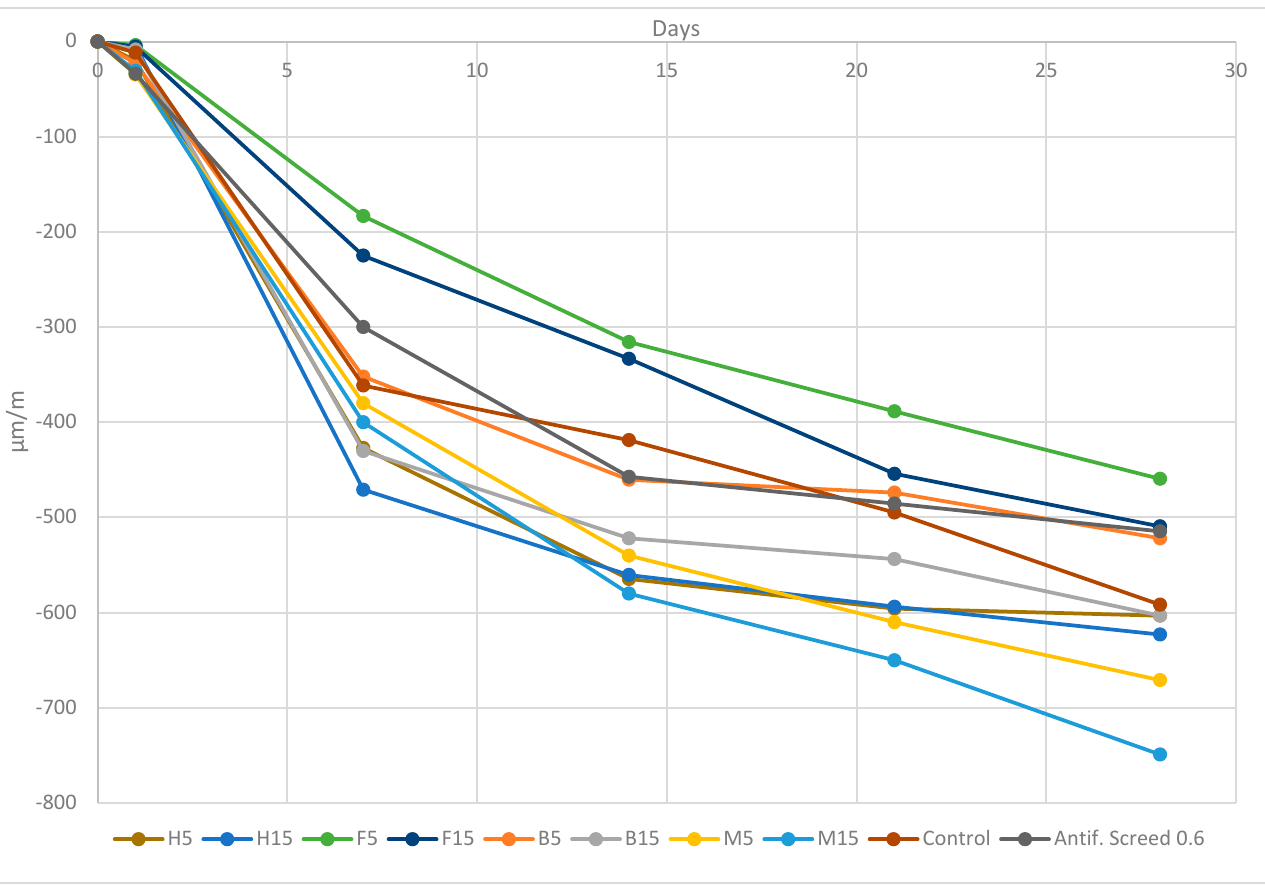
Figure 11. Drying shrinkage measured for FRS 2 kg/m 3 of fiber dosage with vegetal, synthetic fibers and plain mortar at 1, 7, 14, 21 and 28 days.